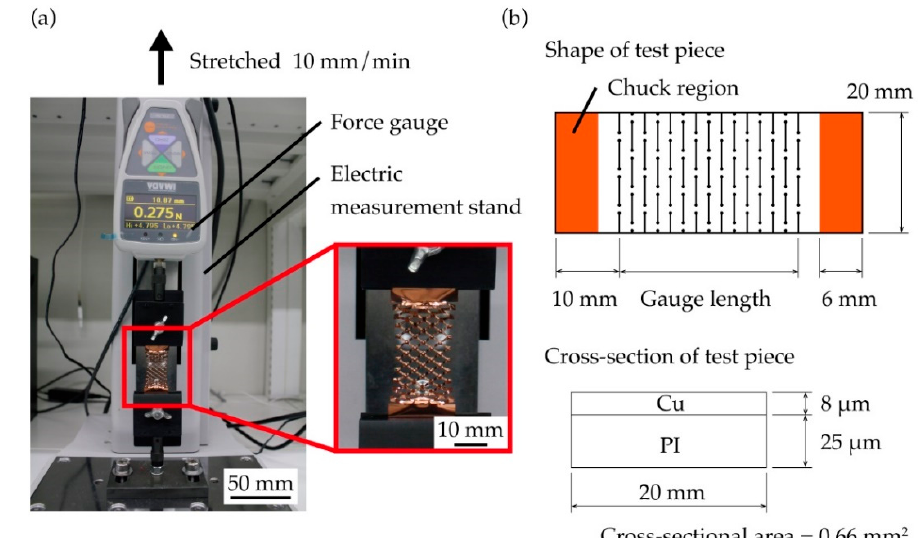
Figure 3. ( a ) Photograph of the tensile test setup, and ( b ) definition of the test piece shape in the tensile test and parameter dimensions.